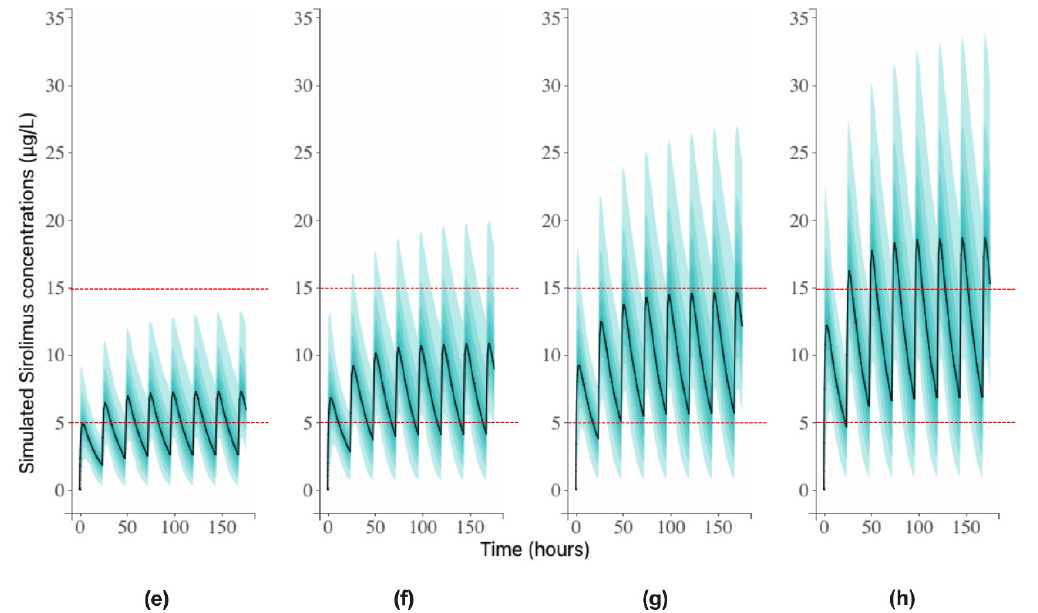
Figure 4. Simulated concentrations versus time after 1.0 mg/m 2 ( a ), 1.5 mg/m 2 ( b ), 2.0 mg/m 2 ( c ), and 2.5 mg/m 2 ( d ) of sirolimus on D8. Dots represent observed concentrations on D8. Simulated concentrations versus time after 1.0 mg/m 2 ( e ), 1.5 mg/m 2 ( f ), 2.0 mg/m 2 ( g ), and 2.5 mg/m 2 ( h ) of sirolimus for 8 days. Dashed lines represent the sirolimus therapeutic range (5–15 µ g/L). Solid line represents the median, and the nine green bands represent each 10% percentile of the 90% simulated concentrations distribution.